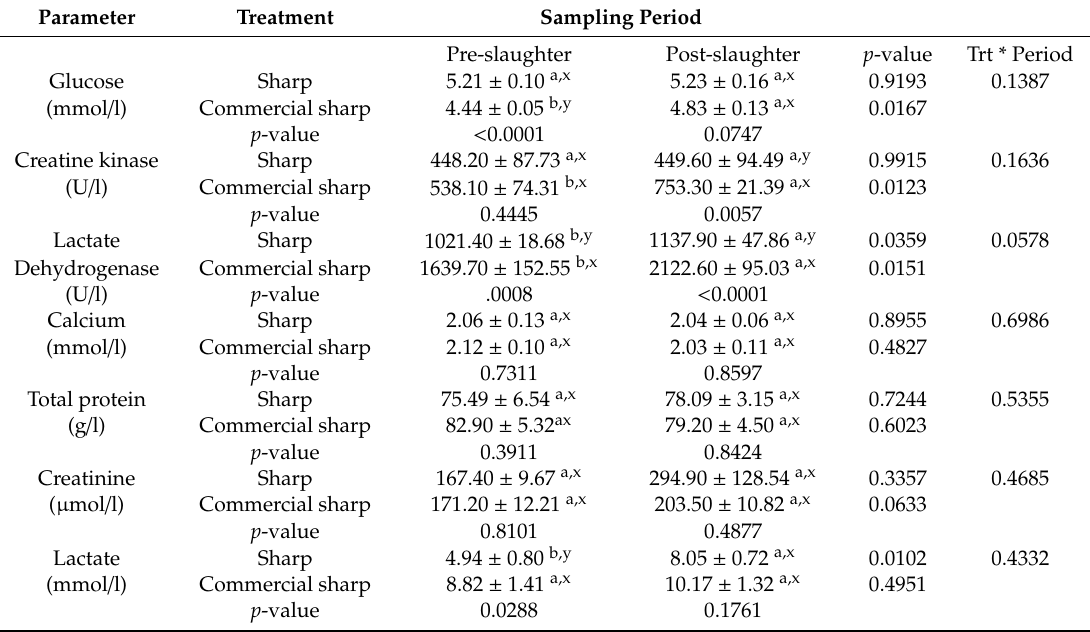
Table 2. Di ff erences in the blood’s biochemical parameters in cattle subjected to di ff erent knife sharpness.